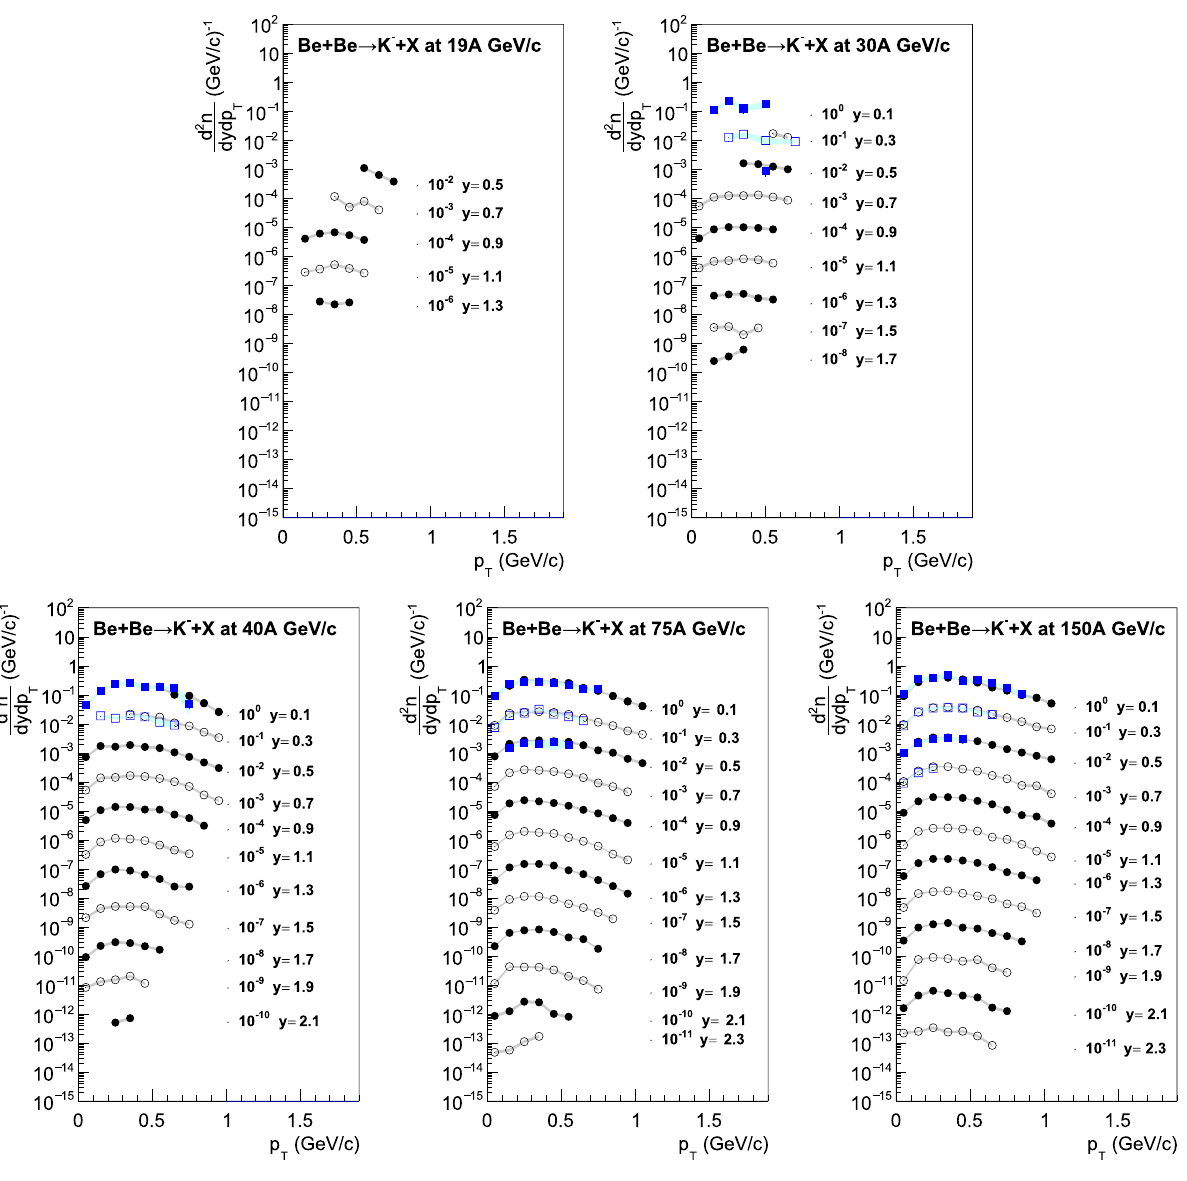
Fig. 21 Transverse momentum spectra in rapidity slices of K − pro- duced in the 20% most central Be+Be collisions. Rapidity values given in the legends correspond to the middle of the corresponding interval.